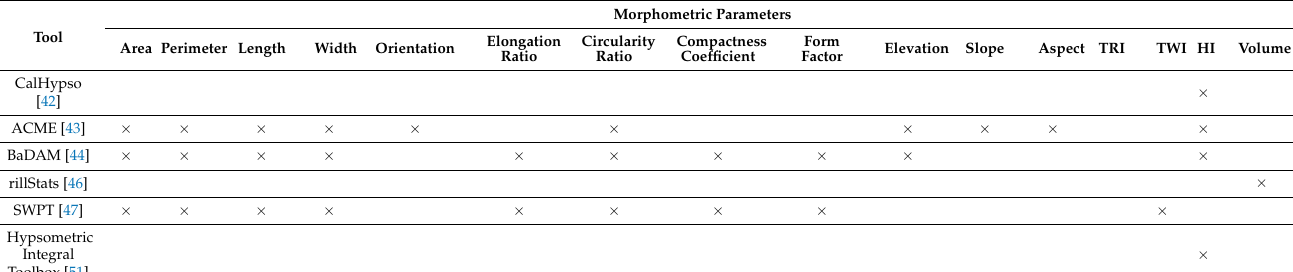
Table 1. Morphometric parameters implemented in the ArcGIS open-source tools for the concave forms analysis. MorphometricParameters Tool Area Perimeter Length Width Orientation Elongation Ratio Circularity Ratio Compactness Coefficient Form Factor Elevation Slope Aspect TRI TWI HI Volume